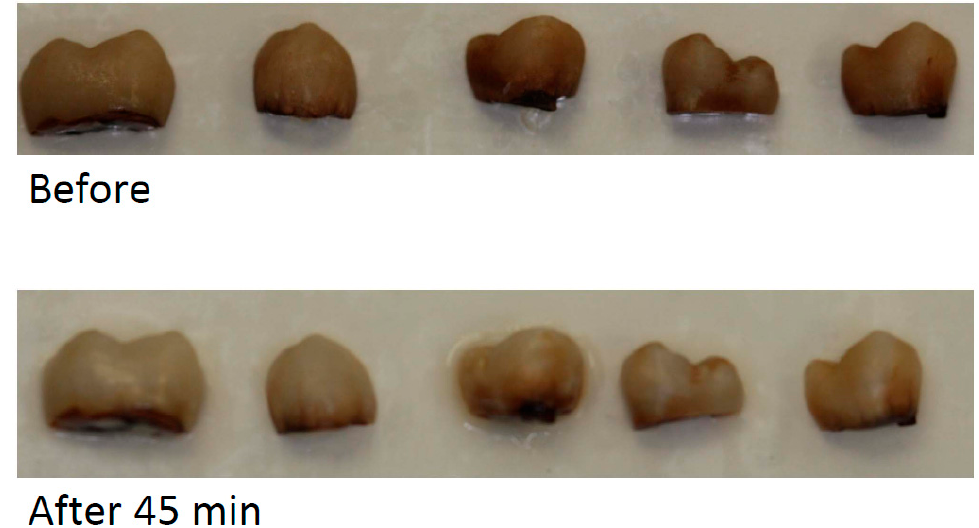
Figure 4. Examples of bleaching effect after 45 min bleaching by at-home bleaching gel.